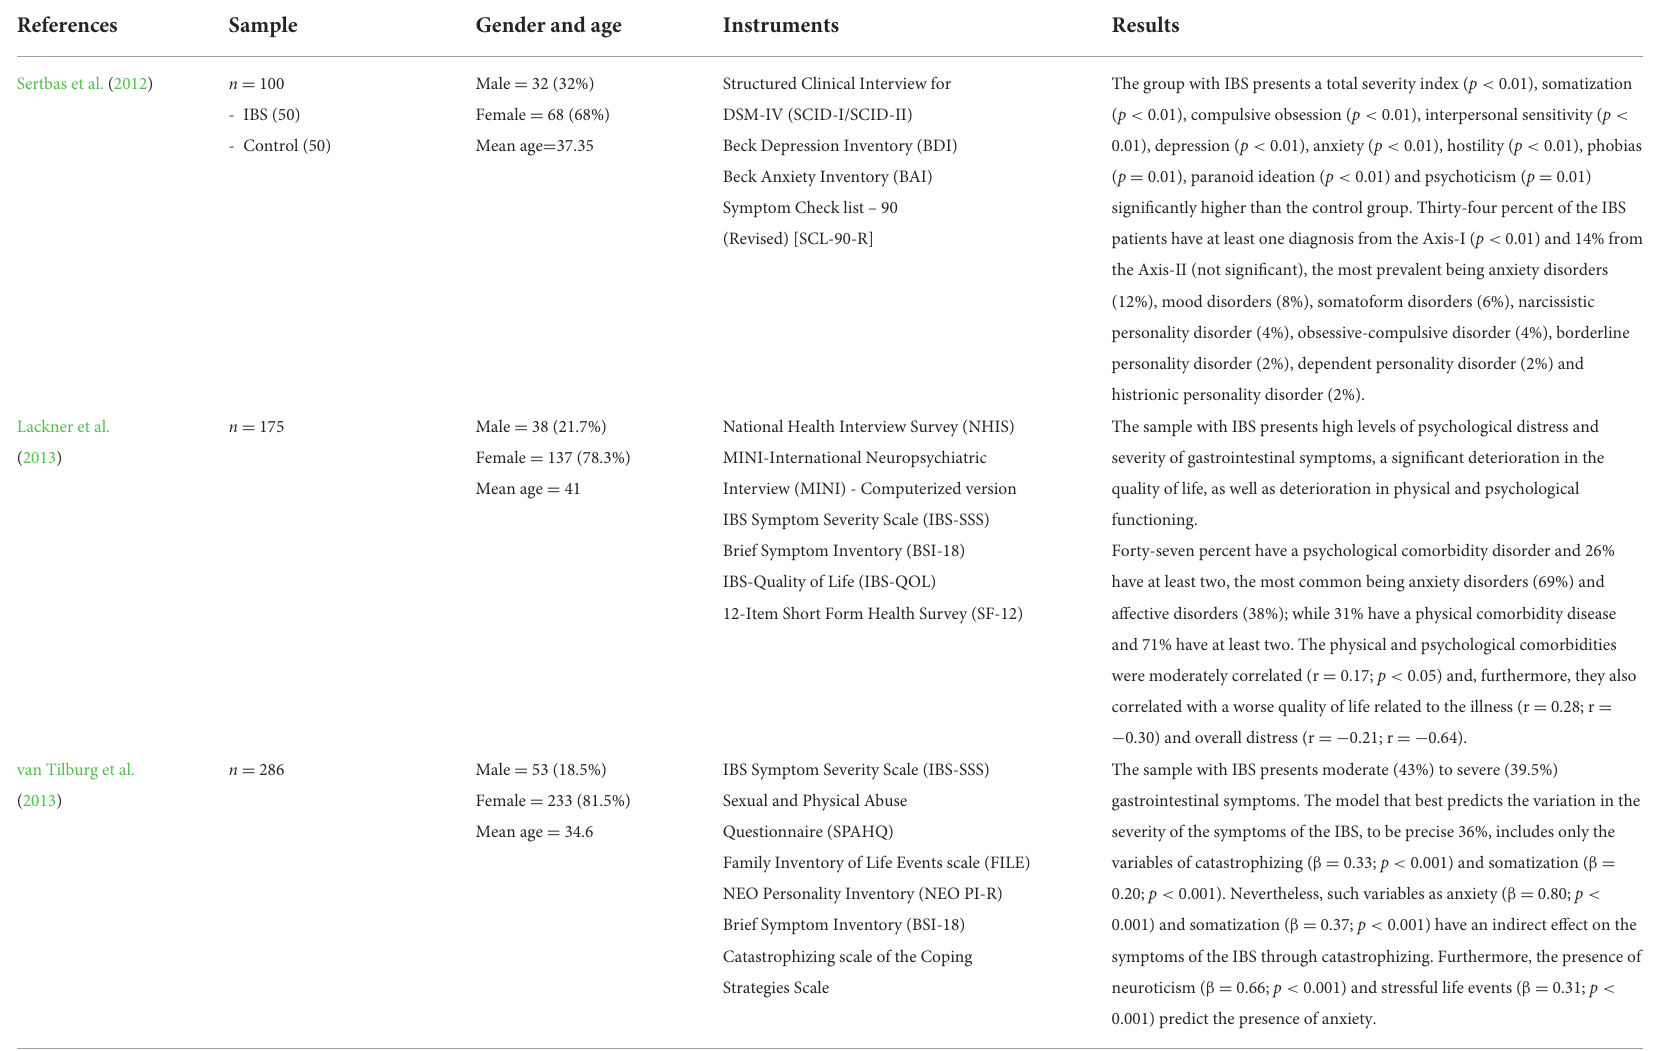
TABLE 2 Psychopathological